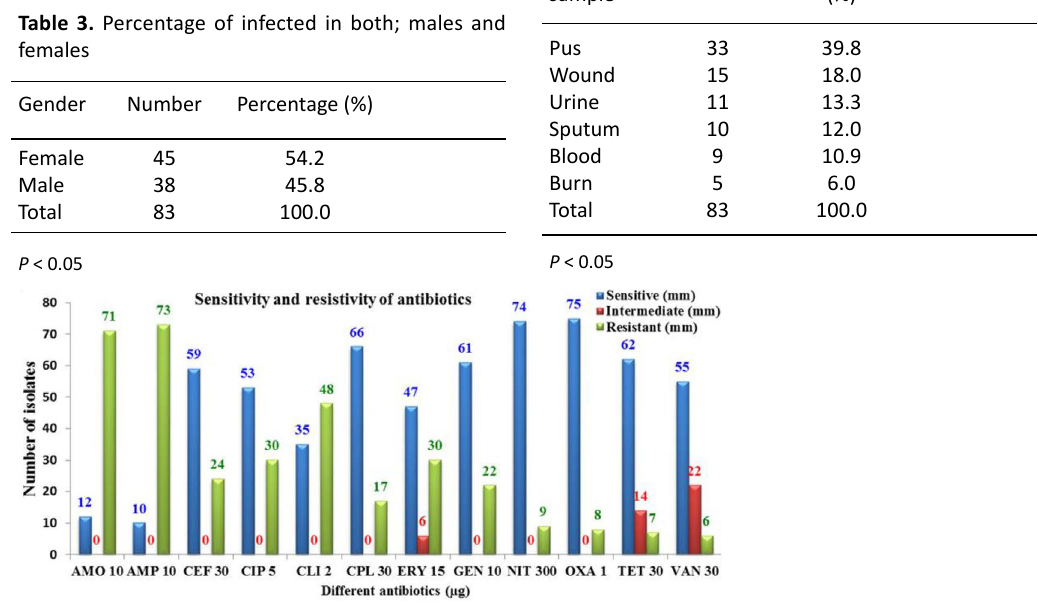
Fig. 1. Antibiotic susceptibility test on the different S. aureus isolates